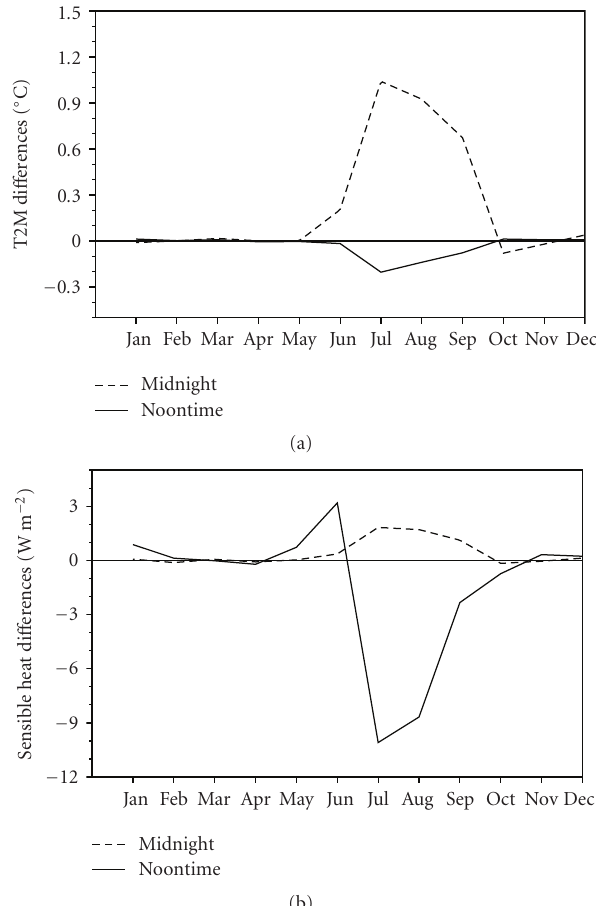
Figure 6: The (a) temperature (unit: ◦ C) and (b) sensible heat flux (unit: Wm − 2 ) di ff erences between the low and high LAI cases (low- high). The solid line is for noontime, and the dashed line is for